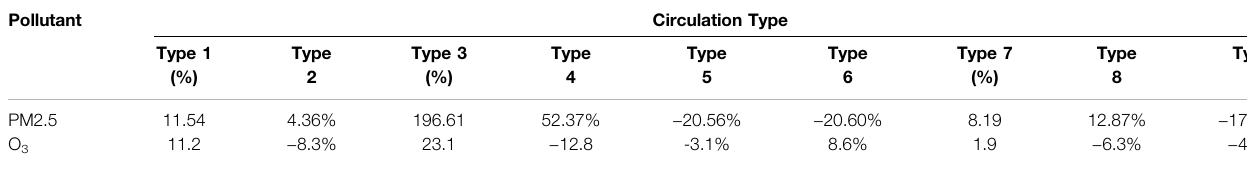
TABLE 3 | Average concentration change rate R of PM2.5 and O 3 under nine circulation